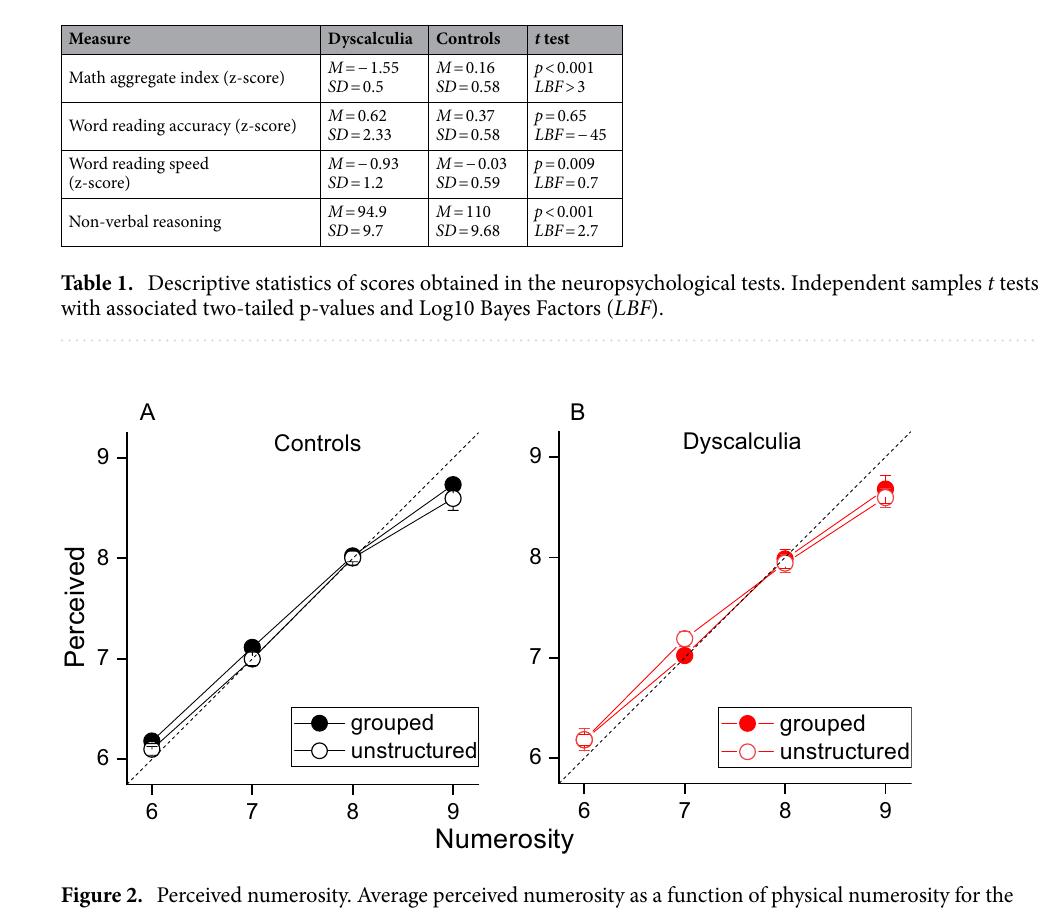
Figure 2. Perceived numerosity. Average perceived numerosity as a function of physical numerosity for the two experimental conditions (empty circles: randomly spaced stimuli, filled circles: grouped stimuli) divided by groups [( A) controls, ( B ) dyscalculia]. Error bars are ± 1